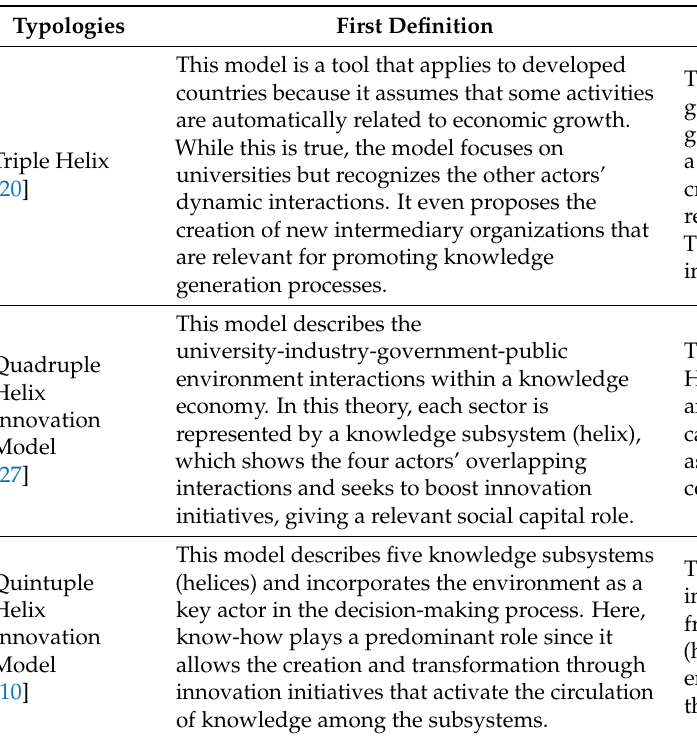
Table A1. Evolution of theoretical models.